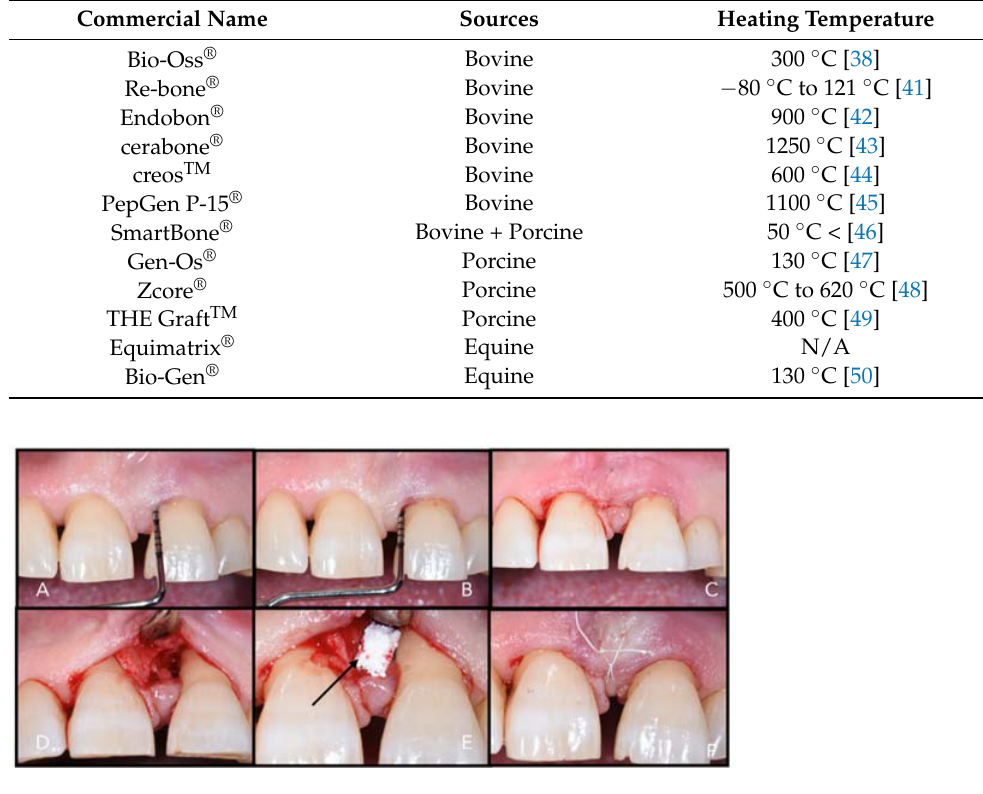
Figure 5. Example of xenografts in a periodontal defect. ( A ) Probing depth, ( B ) bone sounding, ( C ) flap design, ( D ) periodontal defect, ( E ) collagenated bovine bone graft, ( F ) primary wound closure. Table 1. Commercialized bone substitutes and heating temperature according to their production process and the manufacturing protocol.